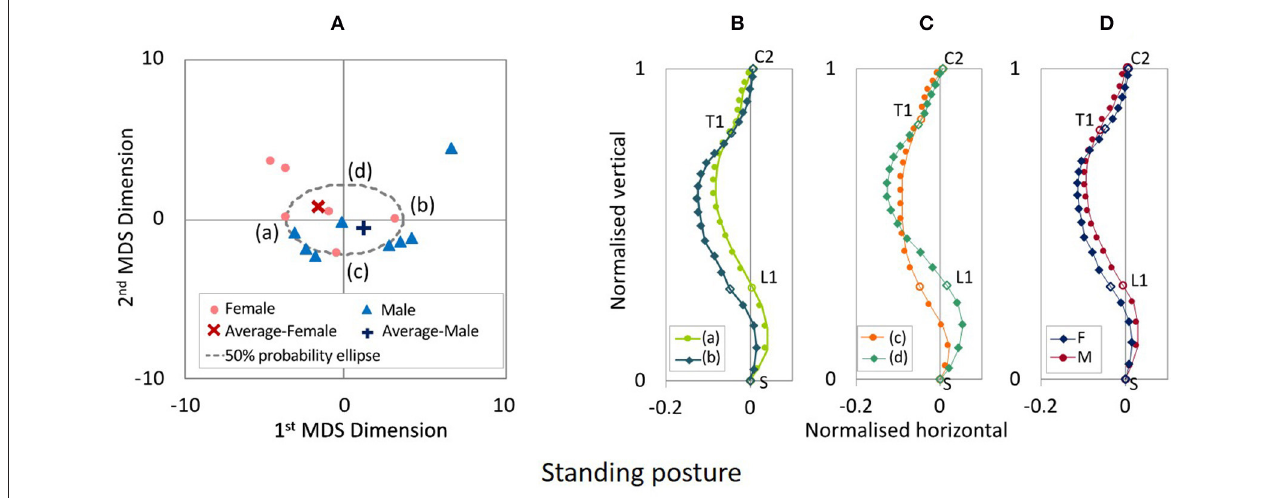
FIGURE 6 | (A) MDS distribution map of spinal alignments for the standing posture. (B) Spinal alignments estimated at the intersections of the 50% probability ellipse with the 1st MDS dimension (a,b) and (C) the 2nd MDS dimension (c,d), and (D) the female and the male average points (F and M).